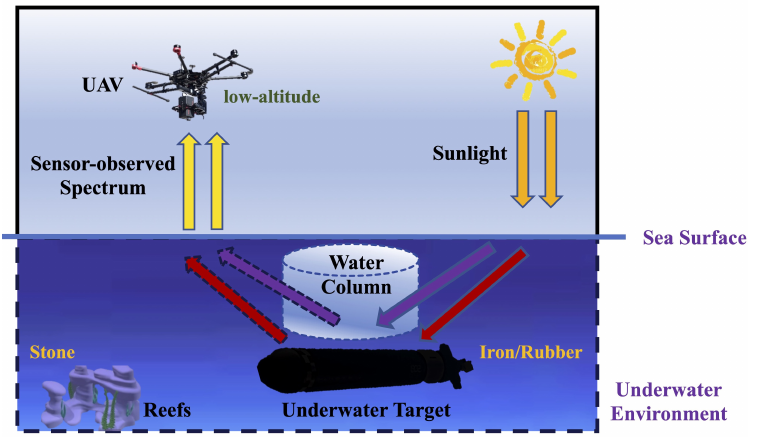
Figure 1. A depiction of the transmission process. Further, r ∞ ( λ ) , k d ( λ ) , k c